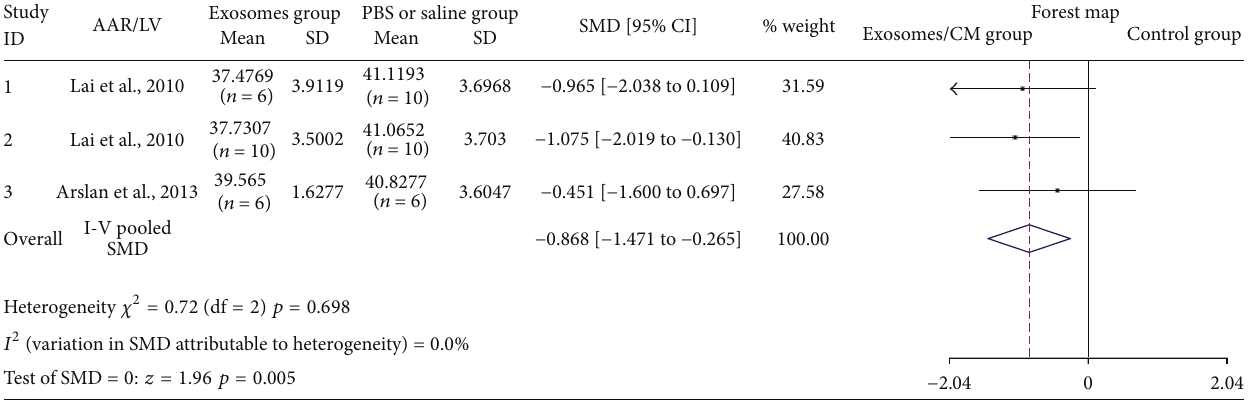
Figure 2: The effectiveness of exosomes on AAR/LV.